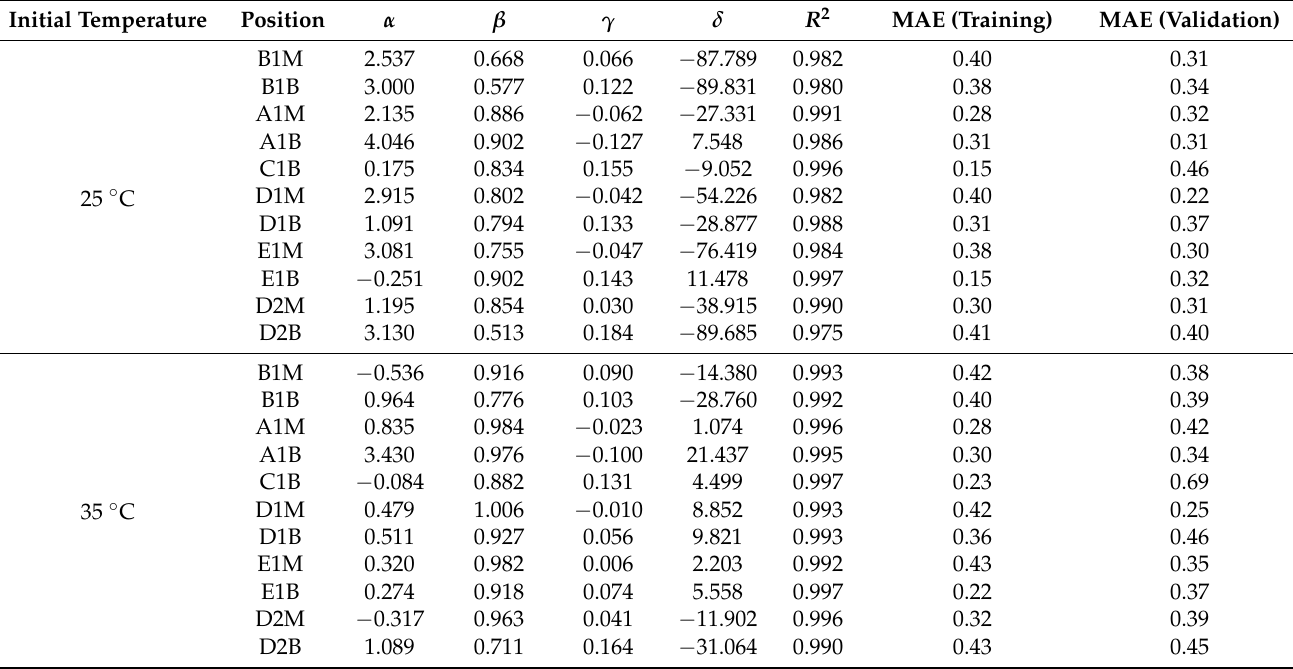
Table 2. The coefficients, R 2 , and MAE of the model for the middle and bottom layers at the flow rate of 770